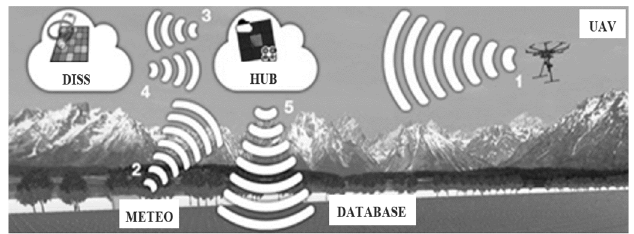
Figure 2. Cloud-based system: UAV equipped with an IR camera (1), a meteorological station (2), a cloud-based software (DISS) that exchanges data from/to the hub (3,4), and a collecting database (5).